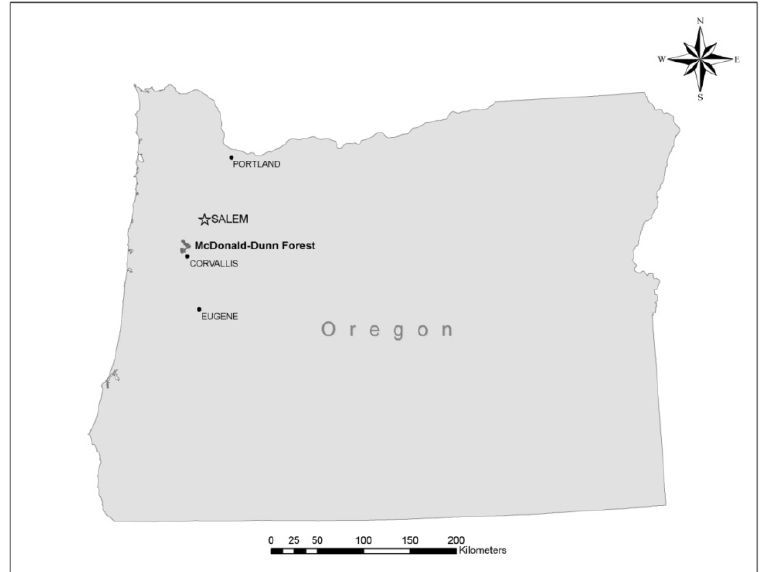
Figure 1. McDonald-Dunn Forest and surrounding communities within Oregon,